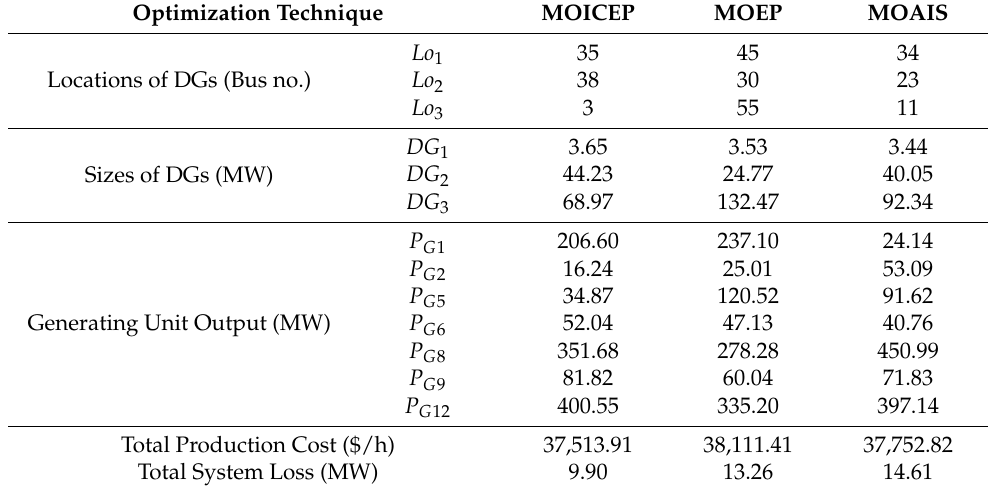
Table 5. Results of the integrated basic ED and DG installation of the IEEE 57-Bus RTS ( w 1 = 0.5 and w 2 = 0.5). Optimization Technique MOICEP MOEP MOAIS Locations of DGs (Bus